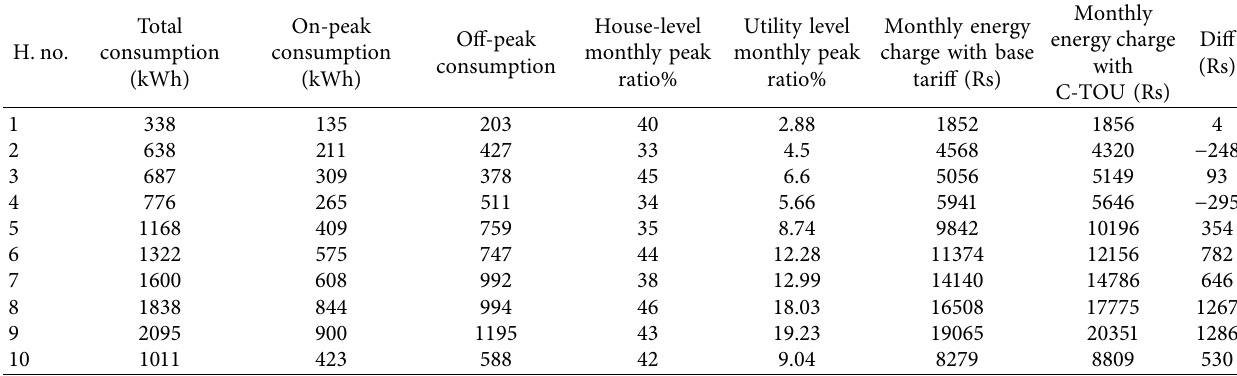
Table 3: Monthly energy charge of 10 customers with and without C-TOU for a summer month. H.